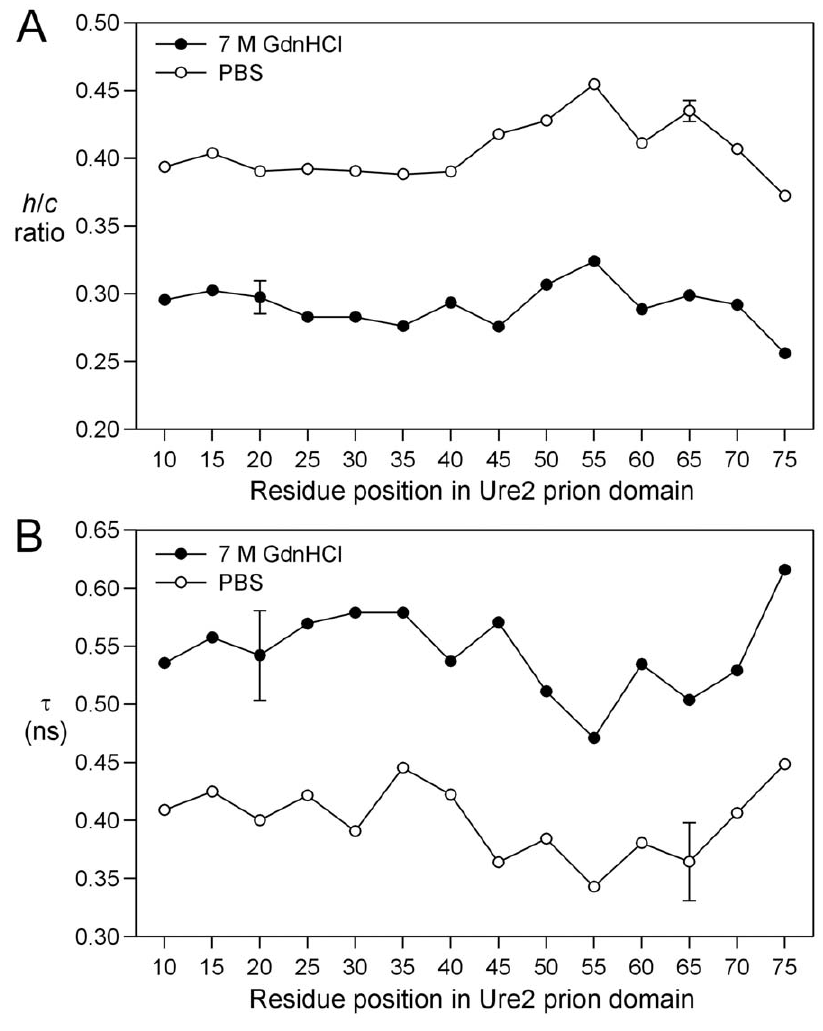
Figure 4. Site-specific spin label mobility in Ure2p prion domain. (A) Plot of the h/c ratio as a function of residue positions in Ure2p 1–89 -M. Note that the h/c ratio is higher in PBS, suggesting higher mobility in PBS. Additionally, the pattern of residue-specific h/c ratio is similar between the two conditions, suggesting similar structures. (B) Plot of correlation time from spectral simulations as a function of residue positions in Ure2p 1–89 -M. The error bars for N20R1 (in 7 M GdnHCl) and N65R1 (in PBS) are the standard deviations of two independent experiments. Other data points are results of single experiments.